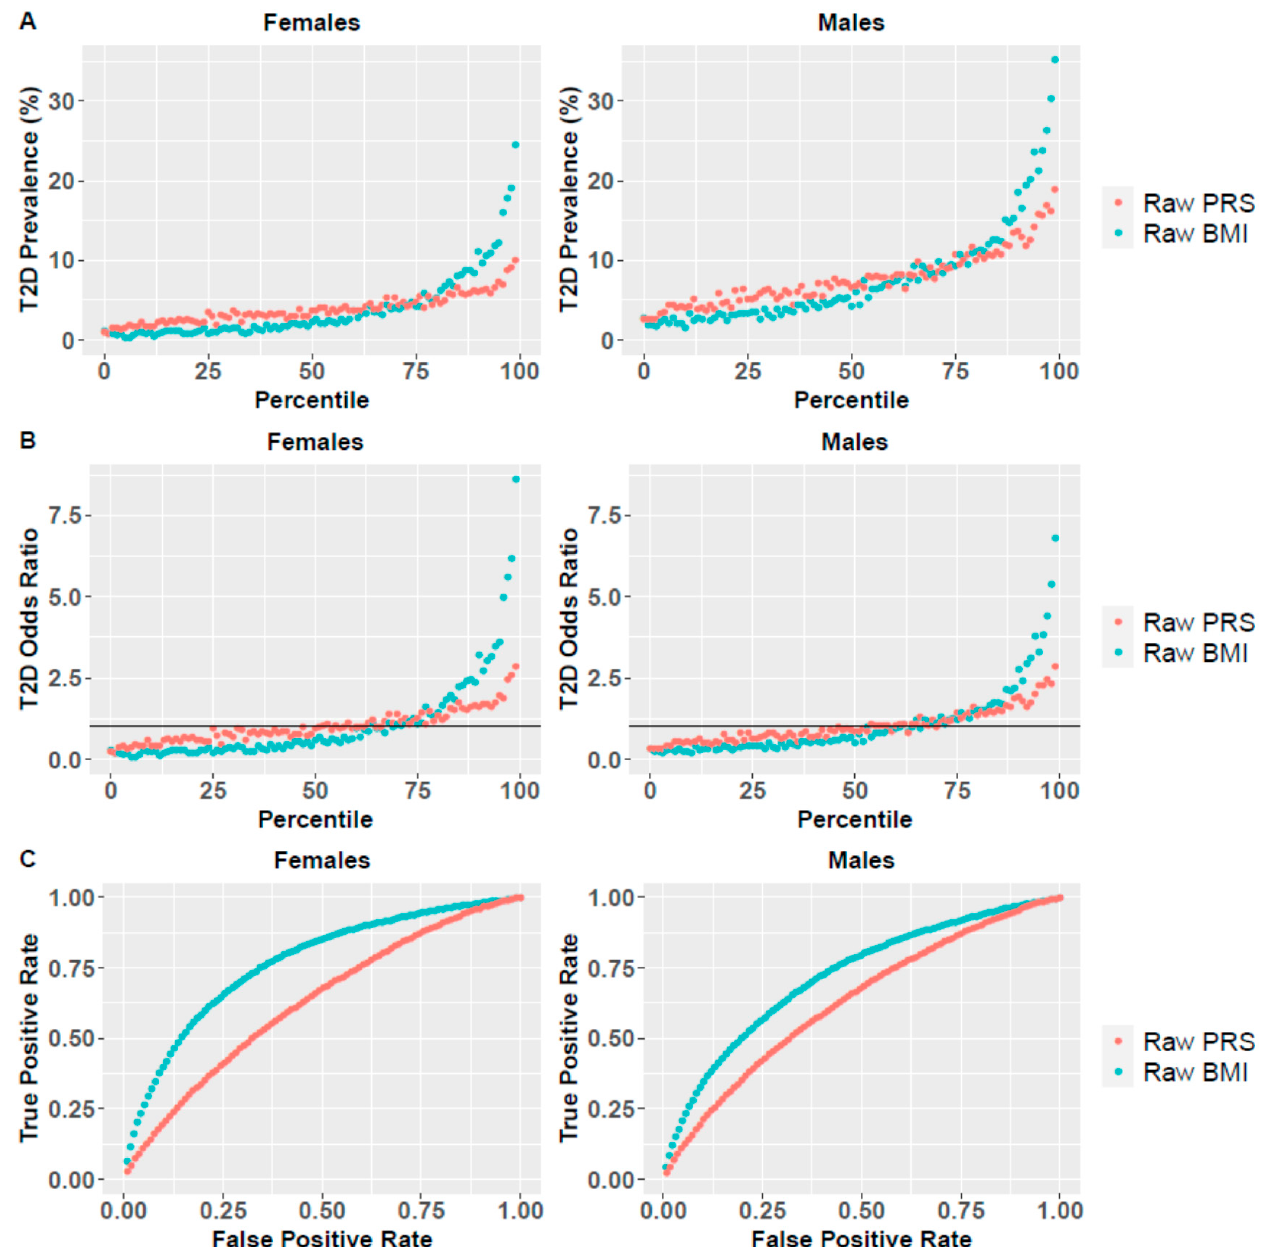
Figure 1. Raw BMI and PRS as predictors for T2D risk. ( A ) T2D disease prevalence based on raw BMI and PRS percentiles for females and males. For each measure (raw BMI and PRS), UKB participants were divided into percentiles, and T2D prevalence was calculated for each percentile. ( B ) T2D odds ratio (OR) for each percentile is shown for females and males, where the horizontal line represents a neutral OR of 1. ( C ) Based on these percentiles, the receiver operating characteristic (ROC) curve is presented for the two measures for females and males, to compare the AUC of the two measures.